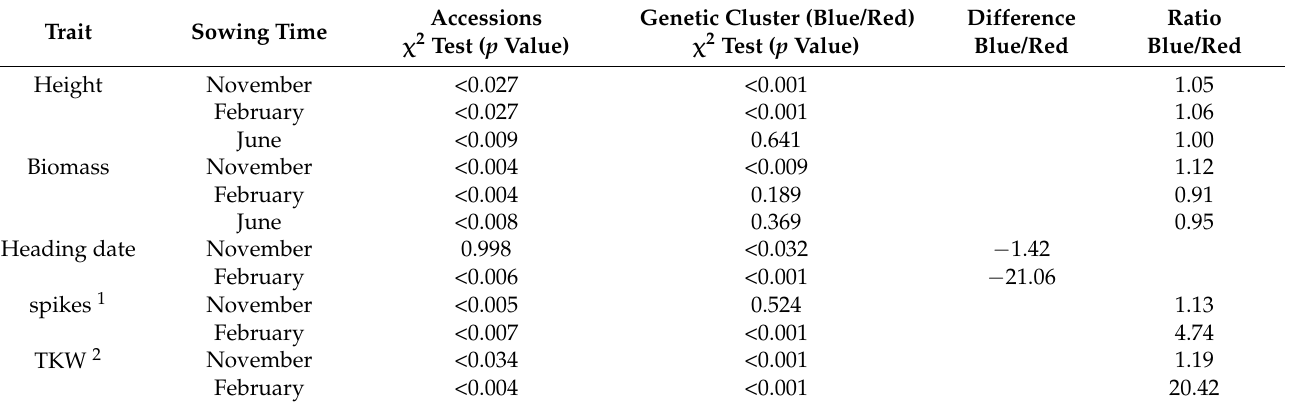
Table 1. Analyses of statistical differences between accessions and genetic clusters. Significance of Kruskal–Wallis tests of null hypothesis of equal trait values between accessions (chi squared accessions) and between genetic clusters (chi squared genetic cluster). The last two columns report the difference and the ratio of the trait values of the blue minus/over the red